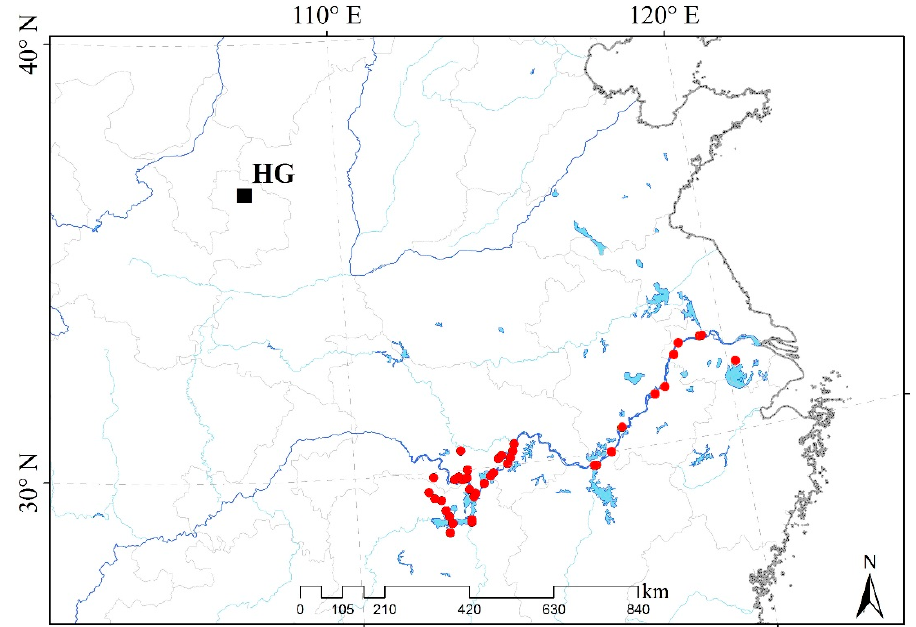
Figure 6. The locations of M. lutarioriparius in native habitats and domestication sites in the HG. The black square represents the experimental field in this study; the red dots represent the collection locations of 41 M. lutarioriparius populations .